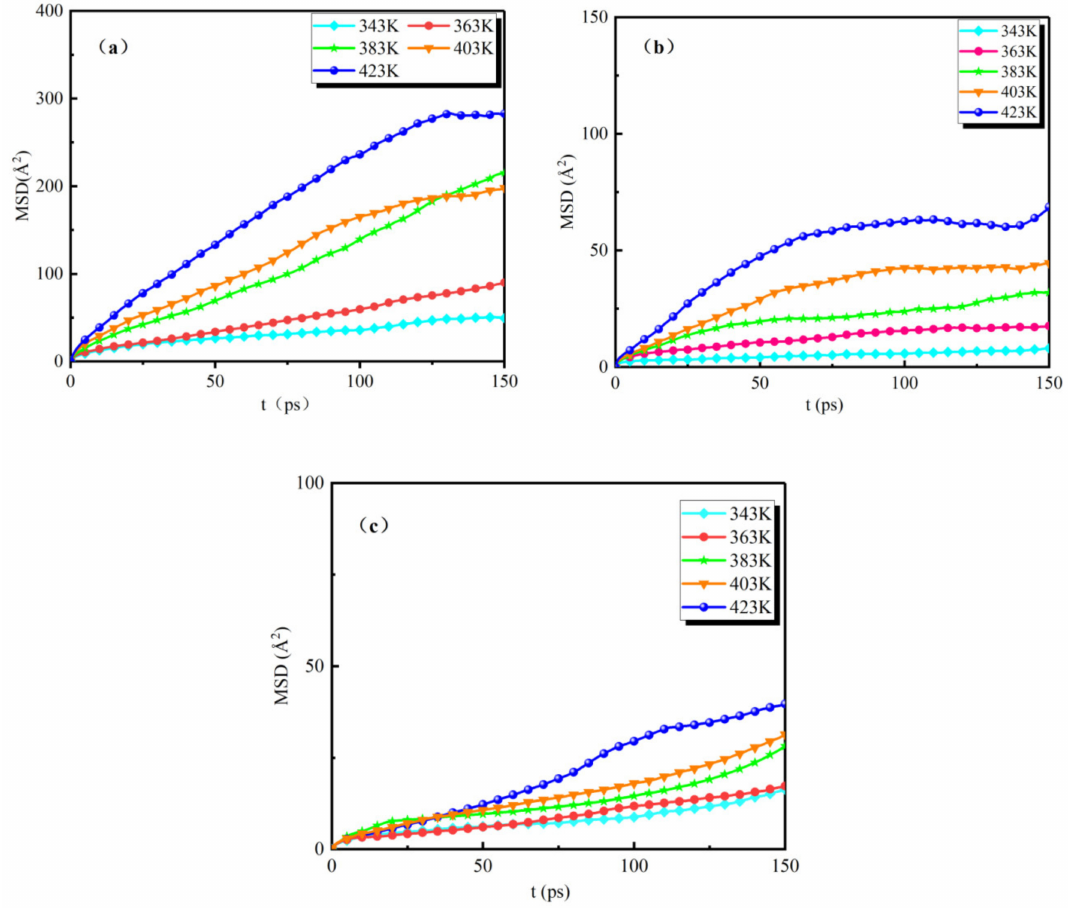
Figure 6. MSD curves of water molecules in three groups of models at different temperatures: ( a ) MSD curves of the oil–water model, ( b ) MSD curves of the Al 2 O 3 nano-modified model, ( c ) MSD curves of the Fe 3 O 4 nano-modified